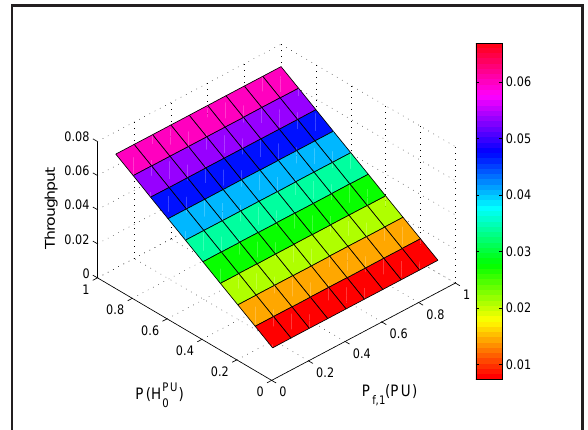
Figure 9. Combined effect of PU’s activity and false alarm probability of CGN at PU on the Throughput of